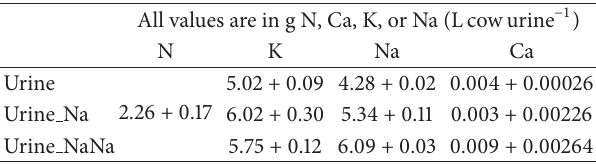
Table 2: The components of cow urine were analyzed. Urine component was measured by atomic absorption.